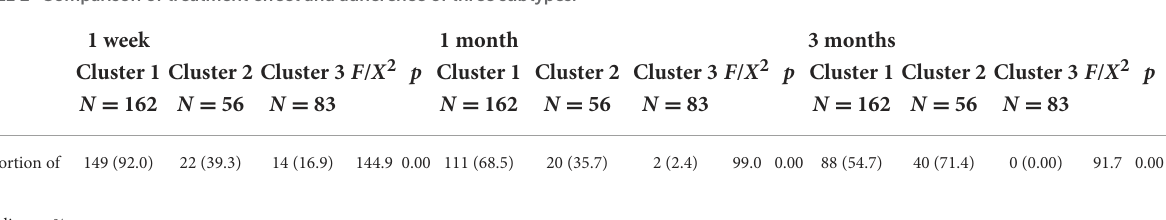
TABLE 2 Comparison of treatment effect and adherence of three